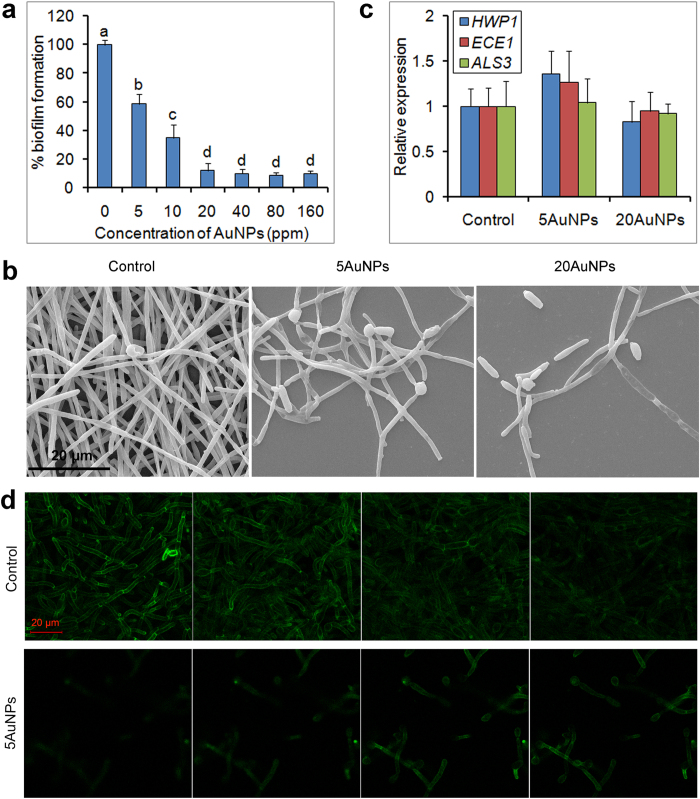
Impaired biofilm formation of C. albicans caused by AuNPs treatment.(a) C. albicans biofilms were formed in polystyrene microtiter plates containing different concentrations of AuNPs, and biofilm activity was measured by XTT assays. (b) AuNPs-treated C. albicans biofilms observed by scanning electron microscopy. (c) Normal expression levels of adhesin genes in the biofilms after 24 h of treatment. (d) Defective localization of the adhesin Hwp1 adhered to the microplate bottom surface, which was observed by confocal microscopy. The error bars indicate one standard deviations (n = 3). Identical letters indicate no statistical differences among treatments (P < 0.05).